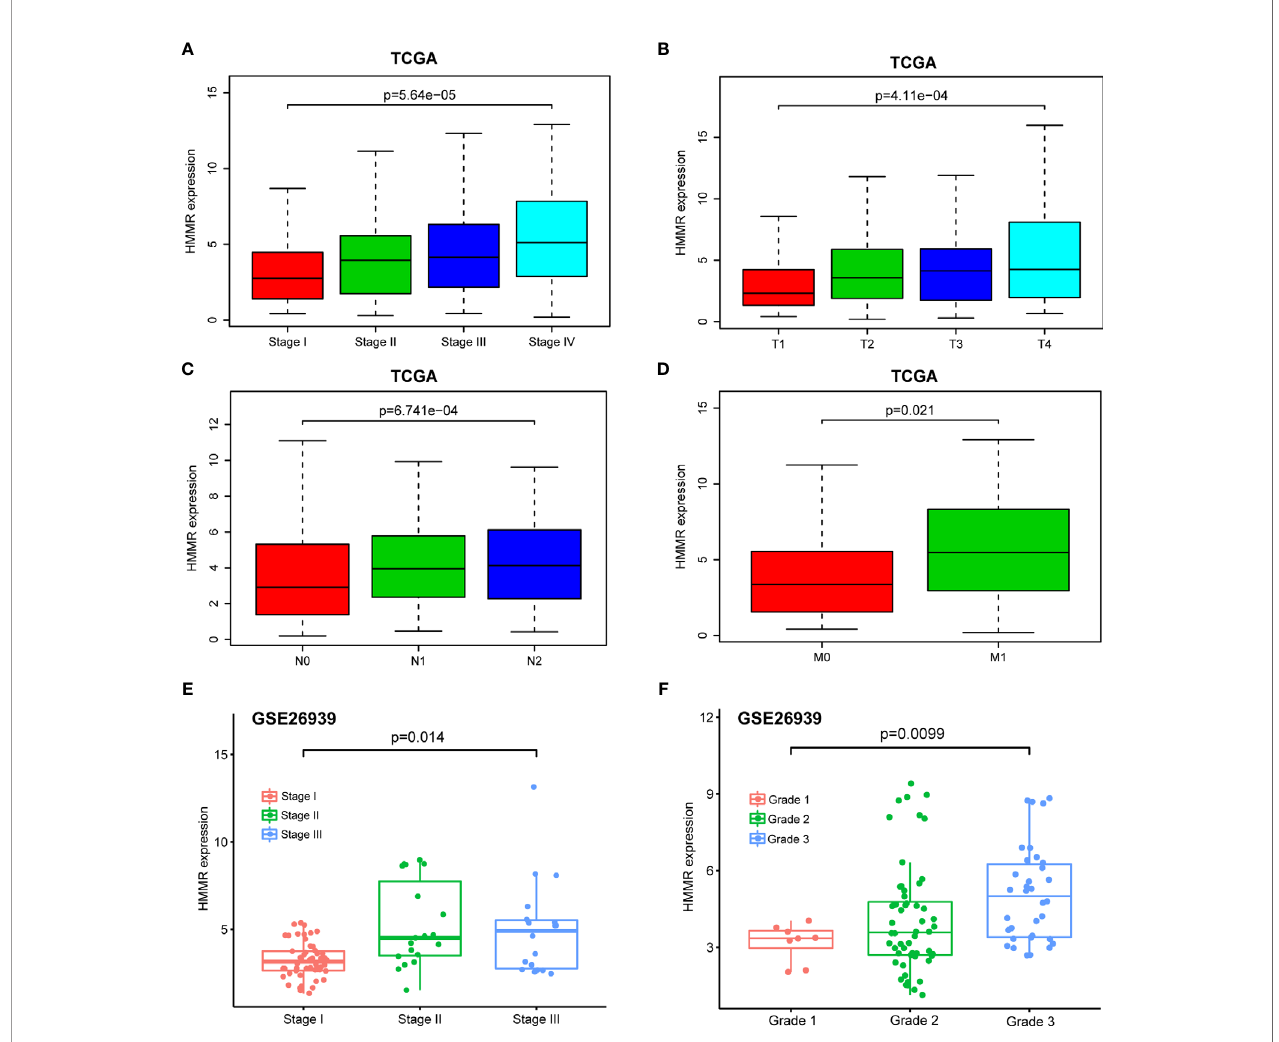
FIGURE 3 | Box plot to evaluate HMMR mRNA expression in LUAD patients based on clinical characteristics. (A) Pathological stage. (B) T classi fi cation. (C) N classi fi cation. (D) M classi fi cation. (E) Pathological stage in GSE26939. (F) Histological grade in